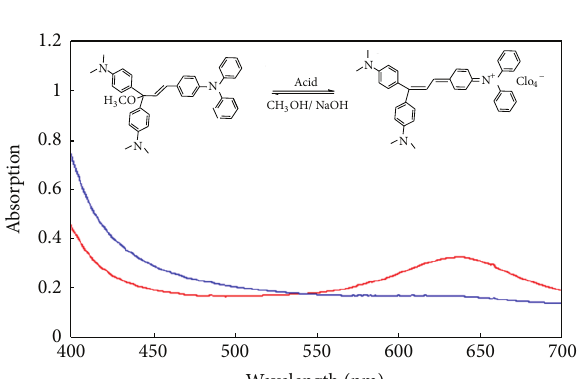
Figure 4: Absorption spectra of methine dye 5 and its leuco form in